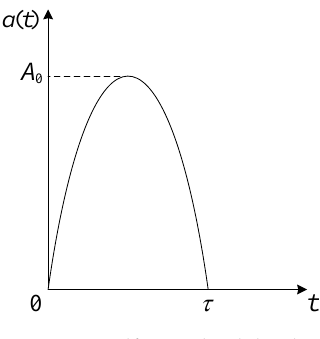
Figure 1. Half-sine shock